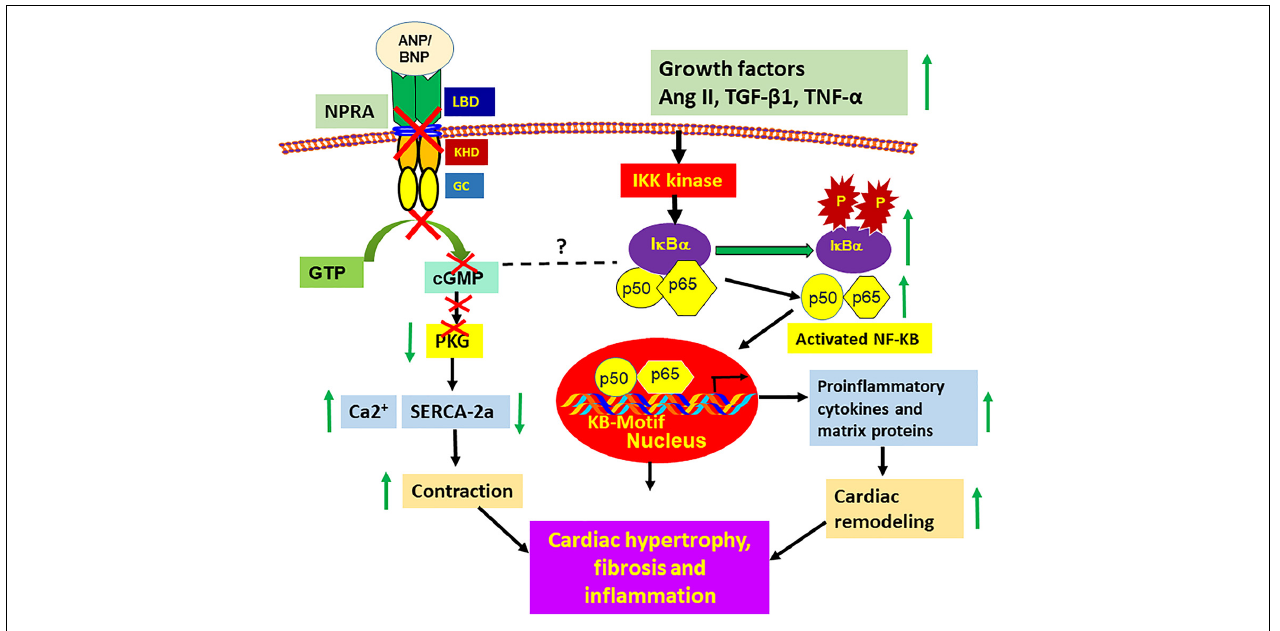
FIGURE 3 | Ablation of Npr1 triggers the activation of proinflammatory pathways that promotes cardiac hypertrophy, fibrosis, and remodeling. Disruption of ANP/NPRA signaling causes unbalanced activation of master transcription factor NF- κ B that initiates the expression of proinflammatory cytokines and matrix proteins; thereby promotes specific cardiac structural and molecular changes in Npr1 − / − mice heart. The activated NF- κ B translocates into the nucleus and promotes the genes transcription and expression of various proinflammatory cytokines and extracellular matrix proteins, including MMP-2 and MMP-9. Increased activation of NF- κ B, thereby promotes medial thickening and perivascular fibrosis, in turn leads to the cardiac hypertrophy, fibrosis, remodeling and heart failure. On the other hand, the absence of ANP/NPRA signaling also simultaneously inhibits SERCA-2a that increases the cytosolic Ca2 + levels, thereby results in the increased contractile activity of the heart, which also promotes cardiac hypertrophy and remodeling. Ang II, angiotensin II; TGF- β 1, transforming growth factor- β 1; TNF- α , tumor necrosis factor- α ; IKK, inhibitory kappa kinase; IKB, inhibitory kappa B, NF- κ B, nuclear factor-kappa B; PKG, cGMP-dependent protein kinase; SERCA-2a, sarcolemmal endoplasmic reticulum Ca2 + -ATPase-2a; MMP-2 and -9, matrix metalloproteinase-2 and −